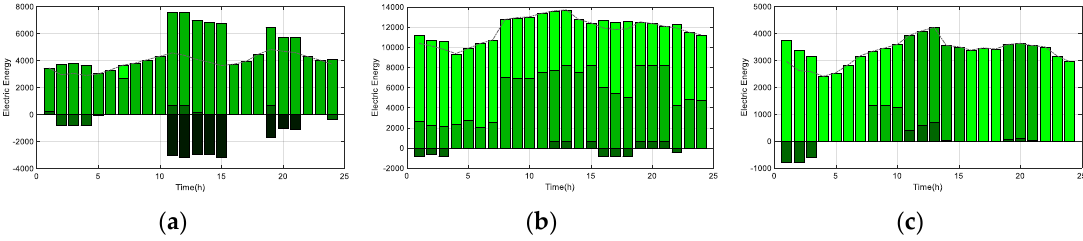
Figure 13. Device output with constant current on a typical season: ( a ) January; ( b ) July; ( c ) October.